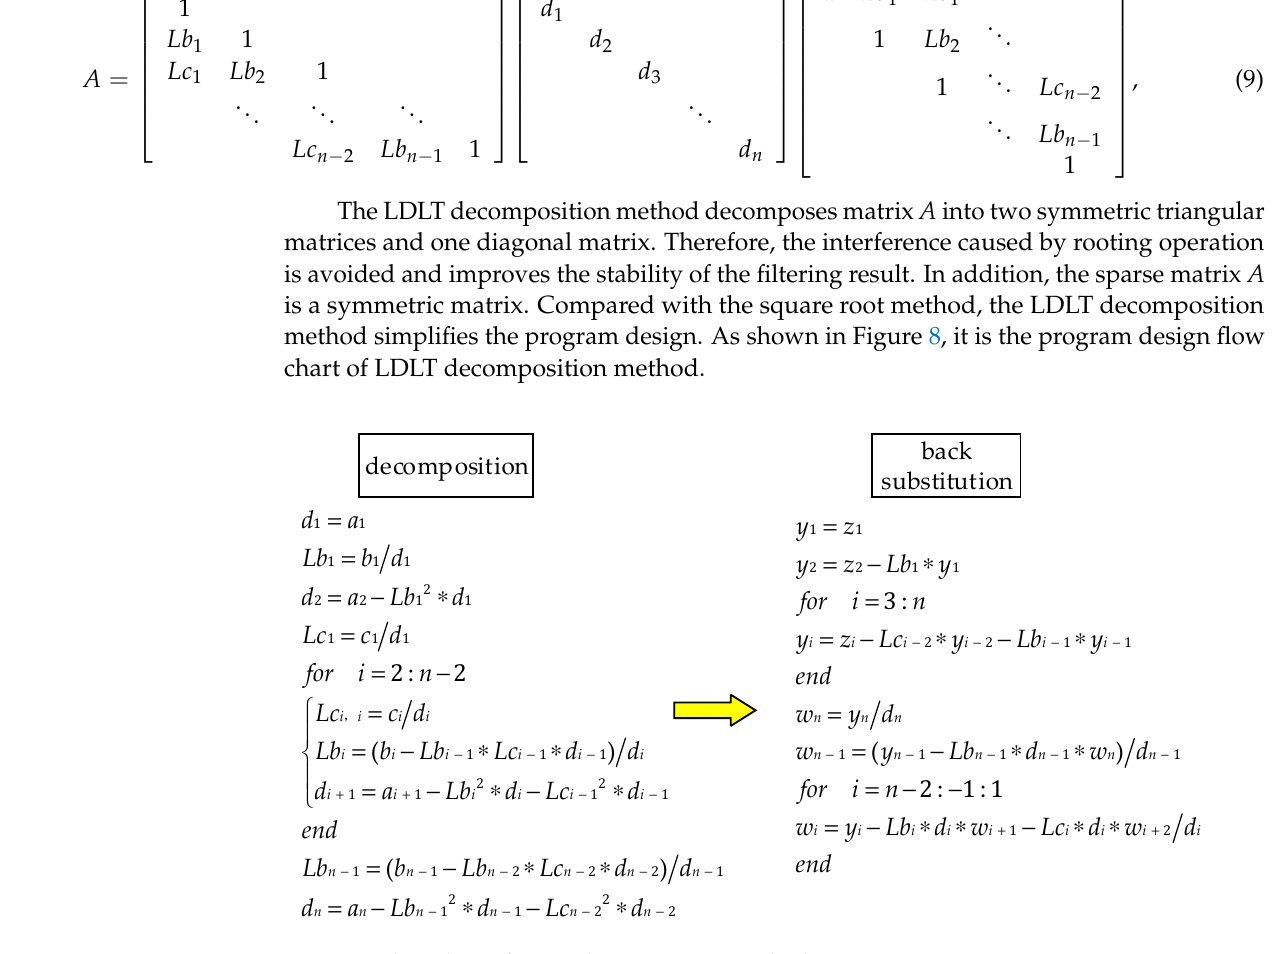
Figure 8. Flow chart of LDLT decomposition method.